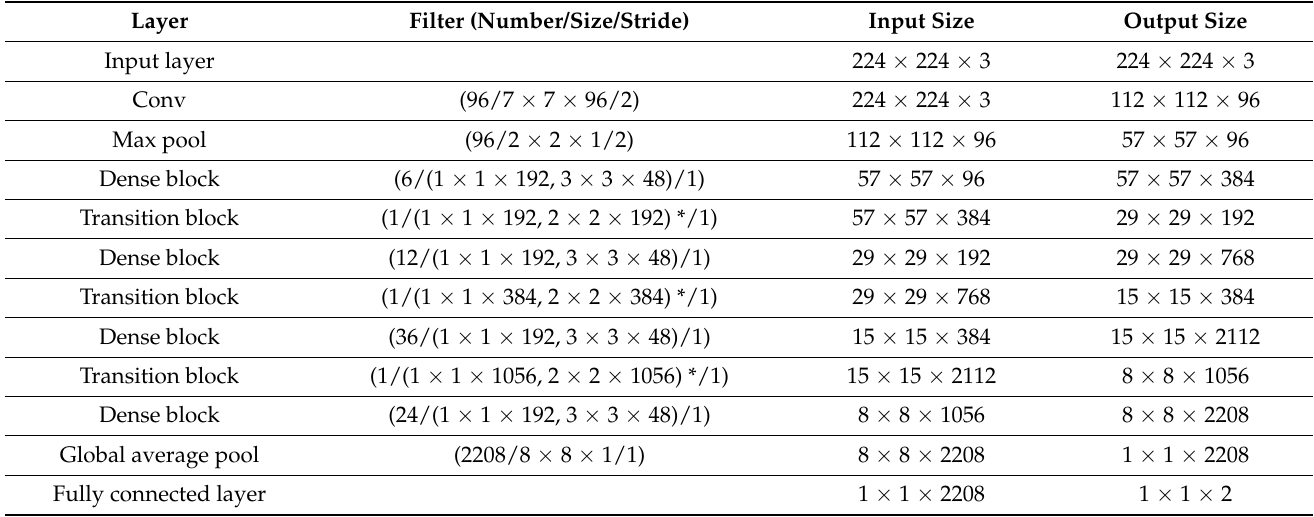
Table 3. Architecture of